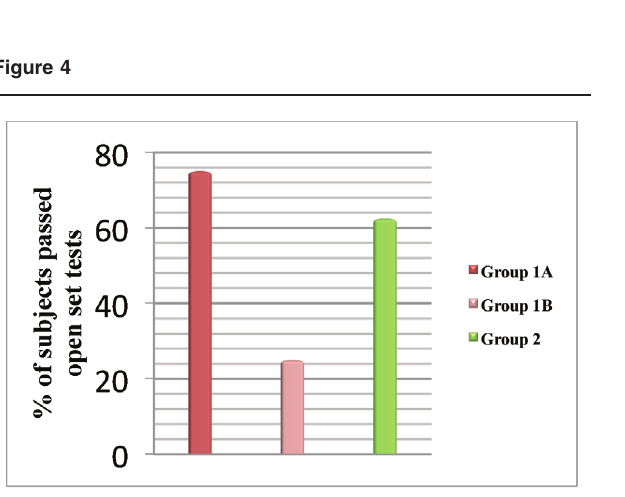
Percentage of subjects that passed open-set-aided speech discrimi- nation tests in the